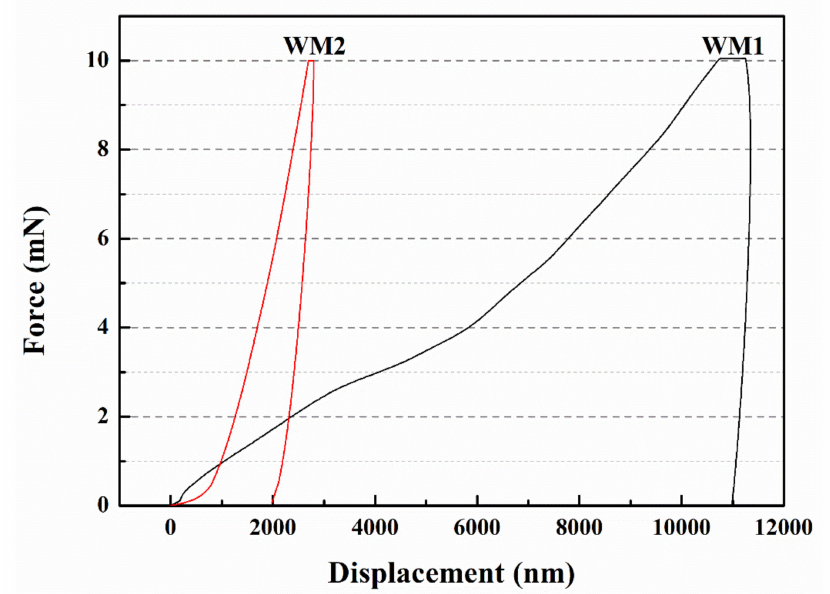
Figure 7. Force-displacement curves of microcapsules.